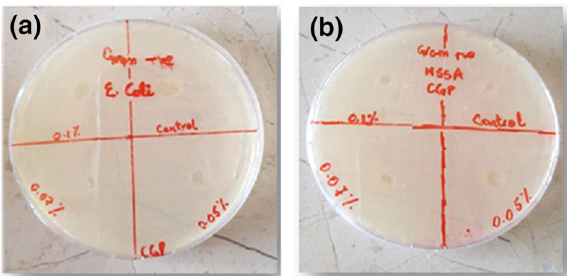
Figure 5. Digital photographs of antibacterial activity of CGP hydrogels ( a ) against E. coli ( b ) against S. aureus.